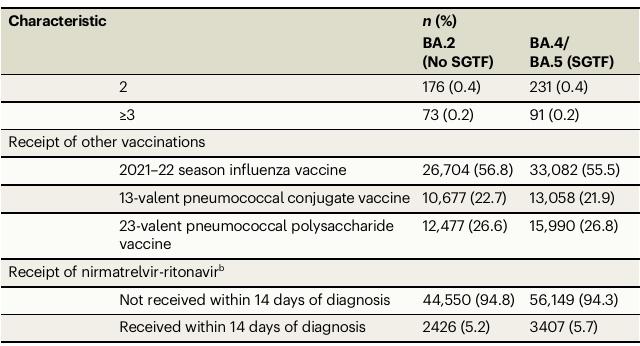
Table 1 (continued) | Characteristics of cases with BA.2 and BA.4/BA.5 lineage SARS-CoV-2